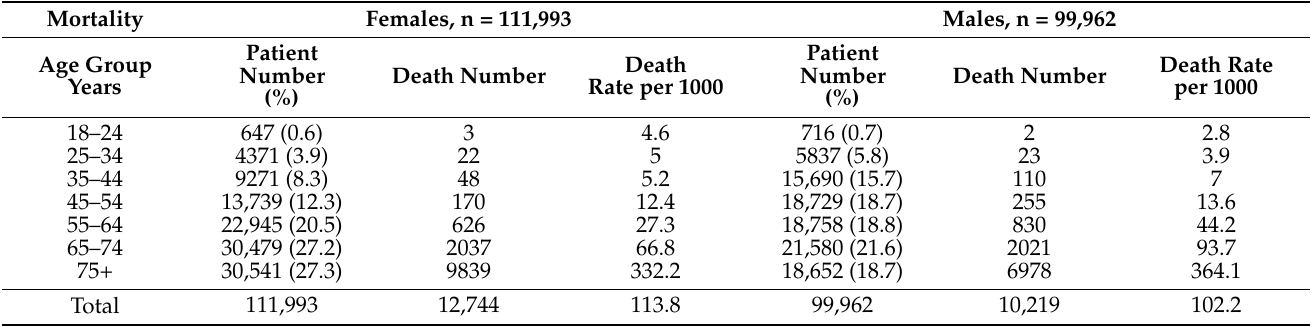
Table 5. Age-adjusted mortality rates among females and males with